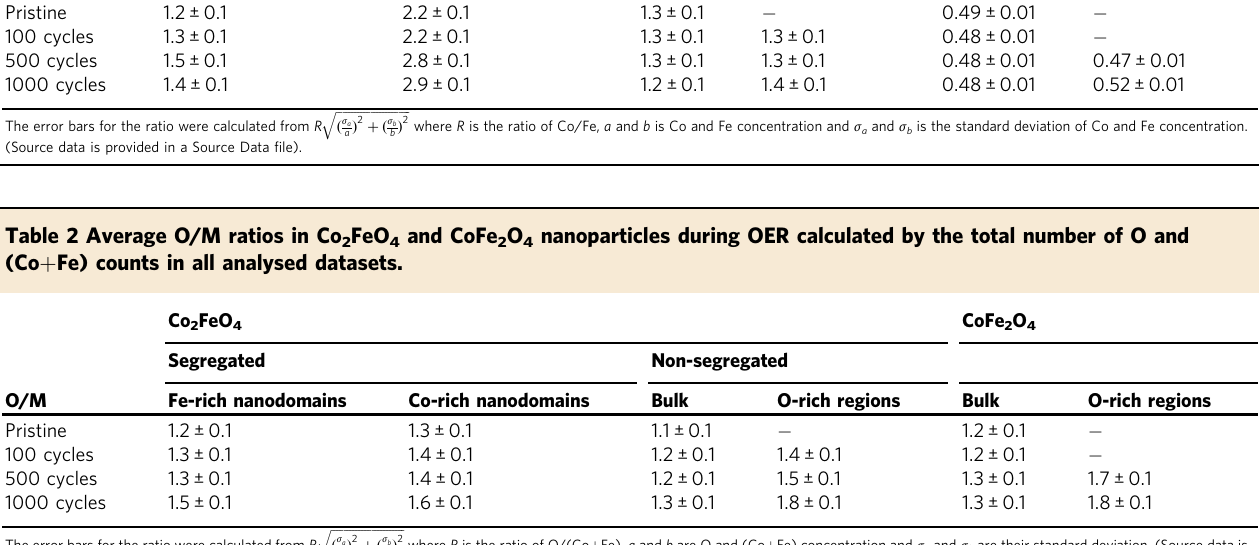
The error bars for the ratio were calculated from R provided in a Source Data fi